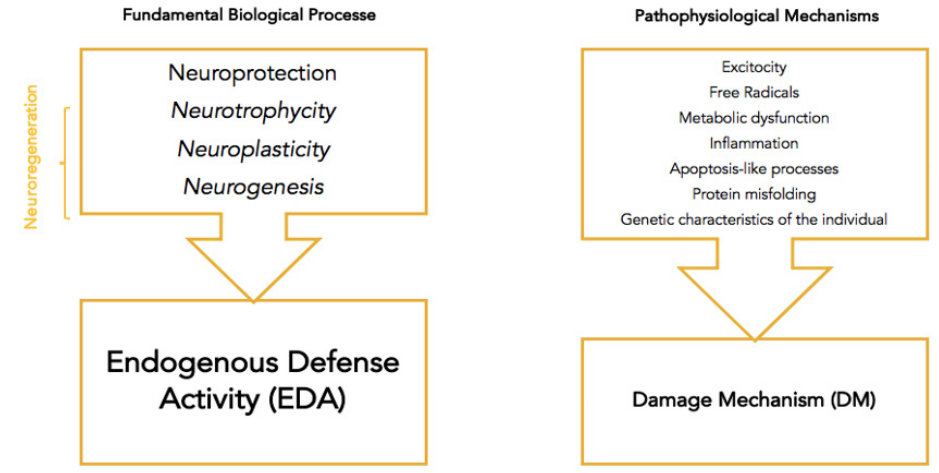
Figure 1. Endogenous defense activity (EDA) and damage mechanism (DM) [5]. Endogenous defense mechanisms consist of absolute and relative